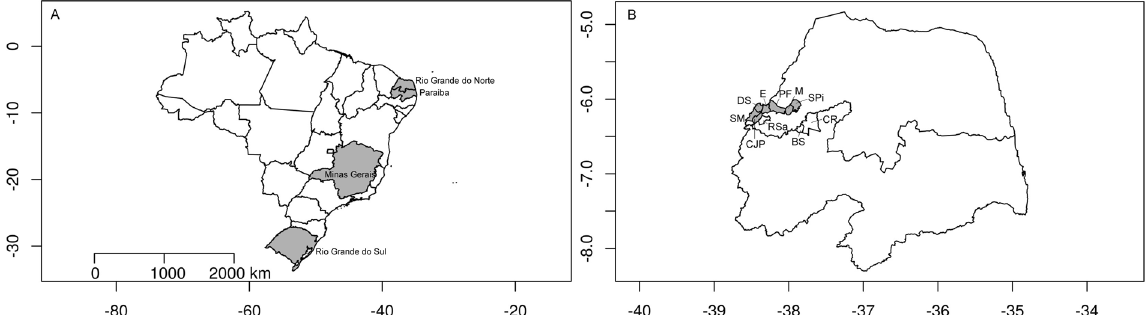
Figure 1. Location of affected Brazilian individuals. ( A ) States in grey have affected individuals. ( B ) State of Paraiba below, inside Catole do Rocha - CR and Brejo dos Santos - BS municipality; State of Rio Grande do Norte with SPOAN-affected individuals, RN Brazilian cluster (grey). Serrinha dos Pintos - SR; Martins - M; Pau dos Ferros - PF, Encanto - E, Doutor Severiano - DR, Sao Miguel - SM, Coronel Joao Pessoa - CJP. Affected with Santos syndrome in Riacho de Santana - Rsa (blank).